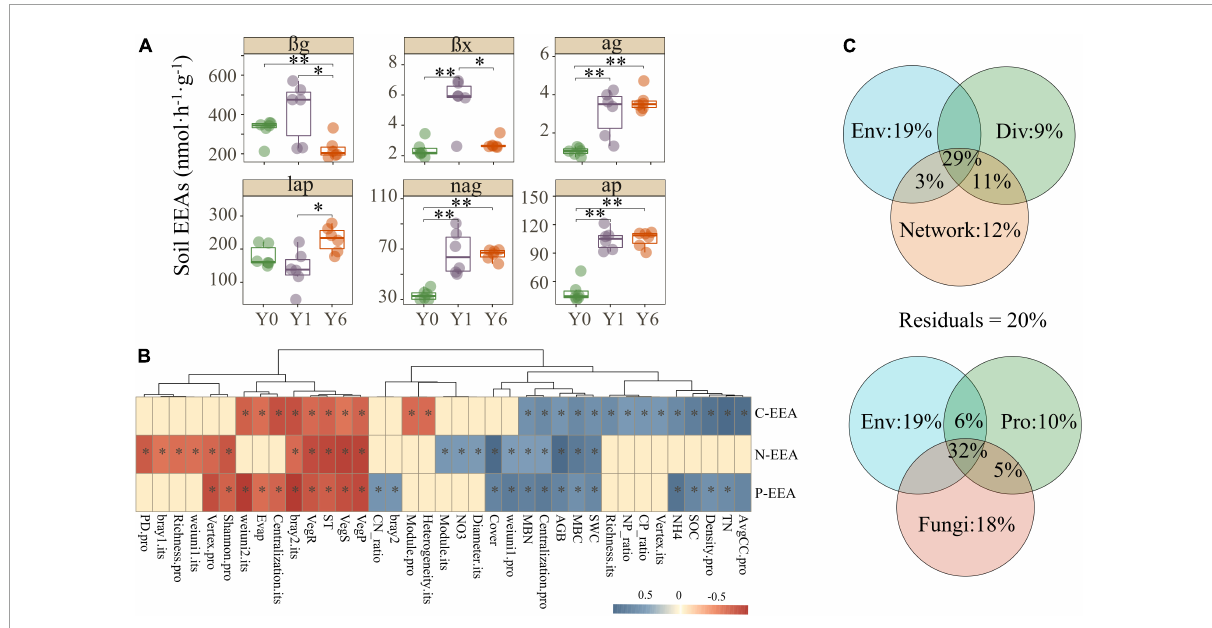
FIGURE5 Soil C, N, and P EEAs and their correlations with environmental characteristics and microbial matrix. Images in panel (A) are the Soil C, N, and P EEAs, images in panel (B) are the correlations among soil EEAs, environmental characteristics, and microbial matrix, and images in panel (C) are the variance portioning analysis. Features with suffix “.pro” and “.fun” indicate prokaryotic and fungal features, respectively. *, **, and ** indicate significant differences at 0.05, 0.01, and 0.001 level, respectively.